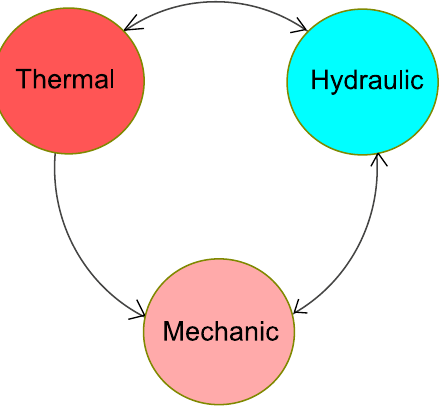
Figure 2. Schematic representation of relevant couplings in shallow geothermal energy (SGE) systems.